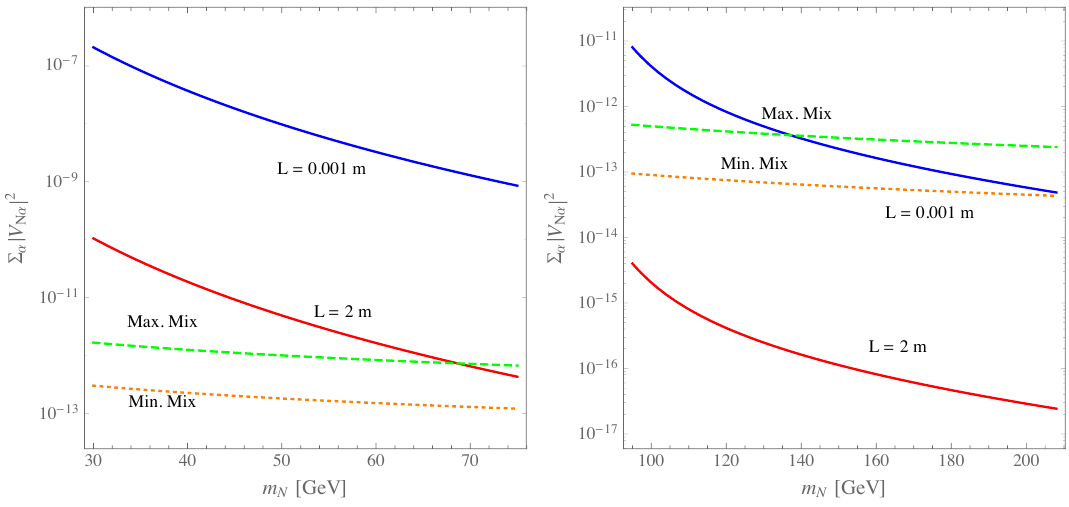
Figure 2 . Sterile neutrino decay length L as a function of its mass ( m N ) and of the active-sterile √ neutrino mixing ( P | V Nα | 2 ) at the LHC with s = 14 TeV , assuming the same model parameters α as in table 1. The blue and red solid lines correspond to L = 1 mm and L = 2 m, respectively. The green long-dashed line (resp. the orange short-dashed line) is the prediction of the model for P | V Nα | 2 in the maximal mixing case (resp. in the minimal mixing case). The predicted decay α length falls in the range [1 mm , 2 m ] when the relevant dashed line lies between the blue and red solid